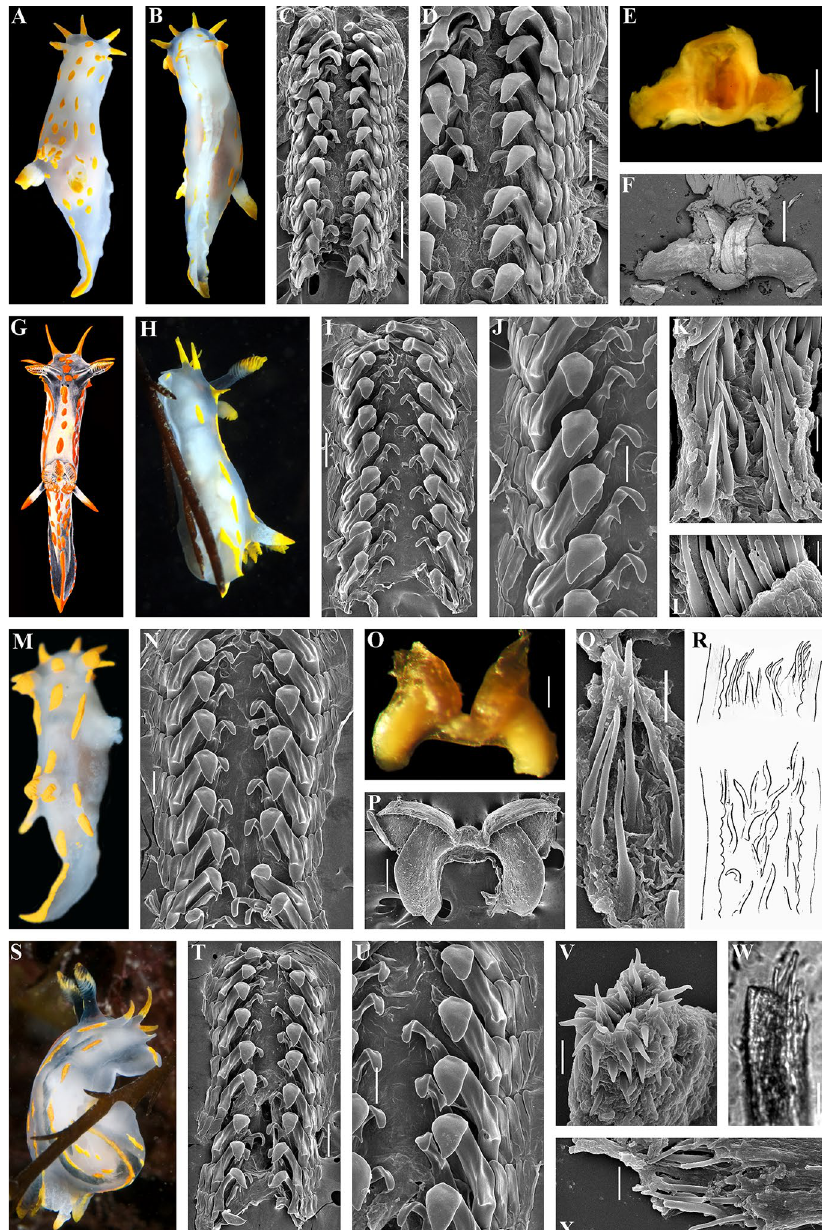
Figure 5. Polycera quadrilineata (O.F. Müller, 1776). External and internal morphology, light and scanning electron microscopy and comparison with data from Thompson and Brown 40 and Bergh 46 . ( A ) Neotype from Norway, Gulen, dorsal view, 25 mm in length, live (ZMMU Op-750). ( B ) Same, ventral view. ( C ) Radula, neotype, scanning electron microscopy (SEM). ( D ) Same, radula details. ( E ) Jaws, neotype, light microscopy. ( F ) Same, SEM. ( G ) Specimen from United Kingdom, Skomer Island, depicted in Thompson and Brown ( 40 : pl 18, a). H. Specimen from United Kingdom, Cornwall, Porthkerris, dorsolateral view, live (ZMMU Op-758). ( I ) Radula, SEM (ZMMU Op-758). ( J ) Same, radula details. ( K ) Copulative spines, SEM (ZMMU Op-758). ( L ) Same, details. ( M ) Specimen from Portugal, Setubal, dorsal view, live (ZMMU Op-760). ( N ) Radula, SEM (ZMMU Op-760). ( O ) Jaws, light microscopy (ZMMU Op-760). ( P ) Same, SEM. ( Q ) Copulative spines, SEM (ZMMU Op-760). ( R ) Spines of a specimen from Norway depicted in Bergh ( 46 , not in copyright), essentially similar to our present data. ( S ) Specimen from United Kingdom, Cornwall, Porthkerris, dorsolateral view, live (ZMMU Op-756). ( T ) Radula, SEM (ZMMU Op-756). ( U ) Same, radula details. ( V ) Copulative spines from the tip of everted part (shorter than common ones), SEM (ZMMU Op-756). ( W ) Copulative spines (common type), light microscopy (FD 041). ( X ) Same, SEM. Scale bars: c, e, f—500 μm, d, i, j, o, p, t—200 μm, k, q, v, w, artist and copyright holder of the images. SEM micrographs and light microscopy photographs: Alexander